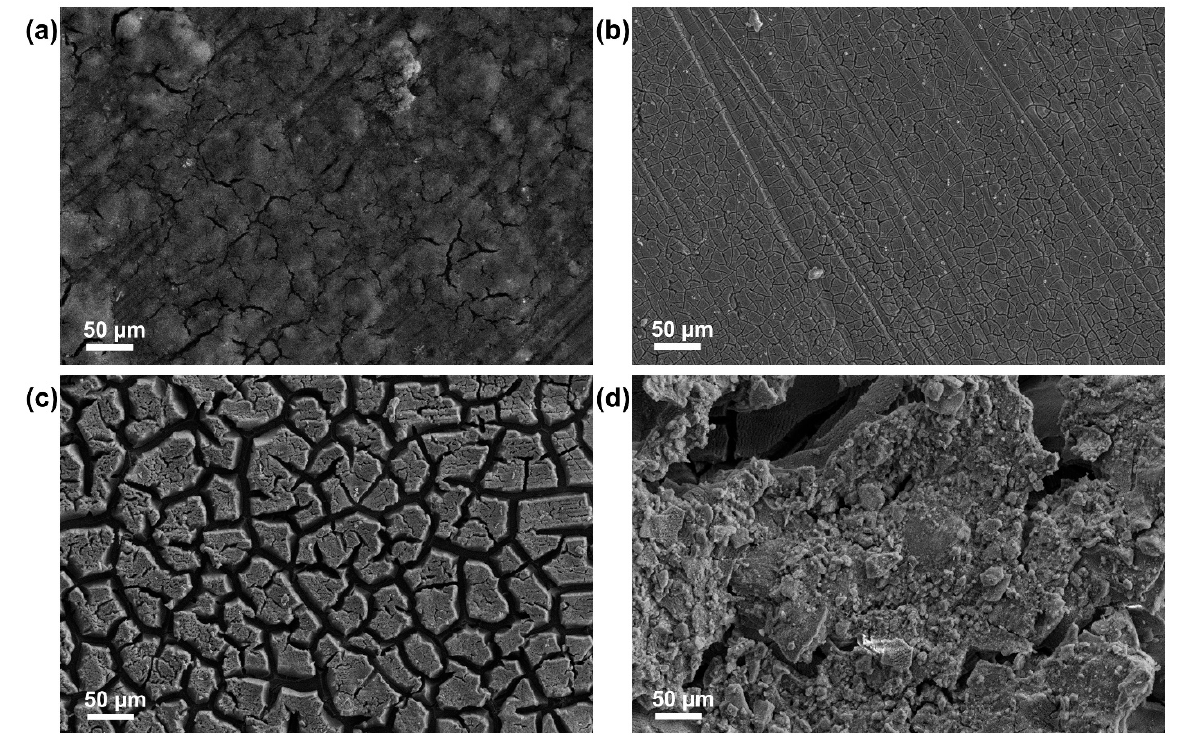
Figure 5. SEM images of the dense Mg-Zn-Zr sample after ( a ) hydroxyapatite coated dried at 25 °C, and phosphate conversion coated with initial concentration of ( b ) 0.12 M, ( c ) 0.16 M, and ( d ) 0.24 M phosphoric acid.